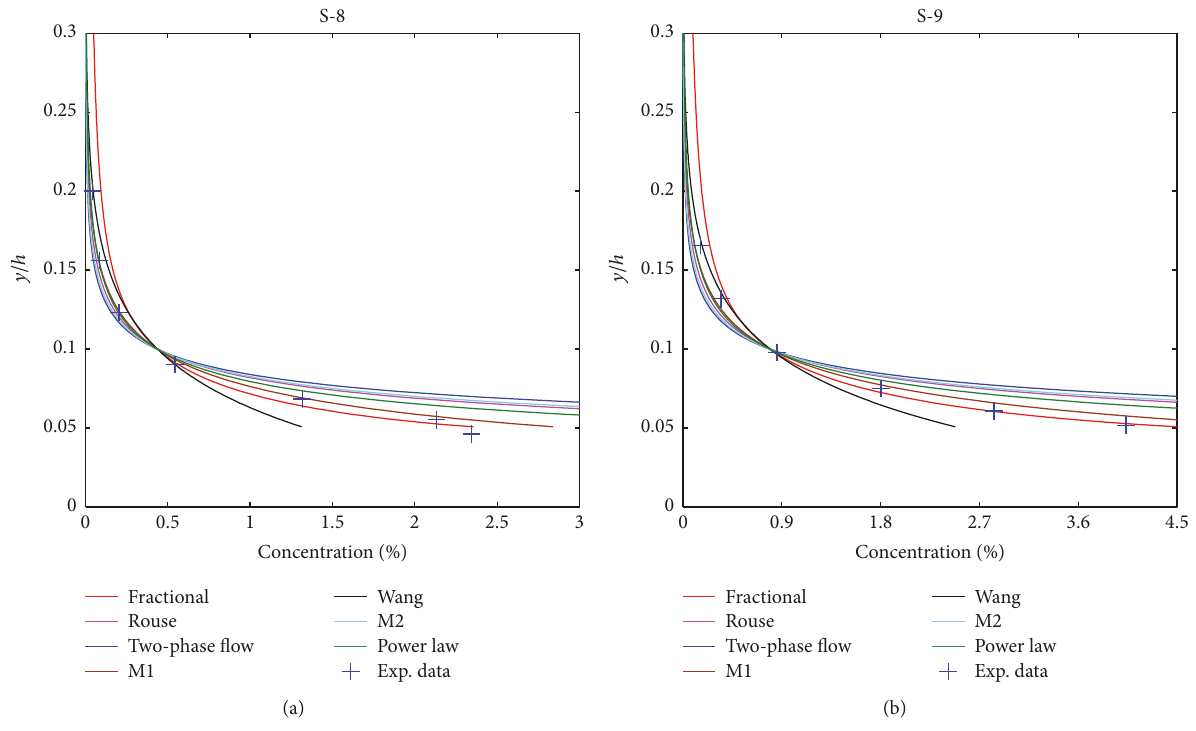
Figure 4: Results of the different models in describing the experimental data of Einstein and Chien [27]. (a) S-2 ( 𝑑 = 1.3 mm), the fractional derivative order 𝛼 = 0.98 , and the reference height 𝑎 = 0.1ℎ . (b) S-3 ( 𝑑 = 1.3 mm), the fractional derivative order 𝛼 = 0.94 , and the reference height 𝑎 = 0.1ℎ .